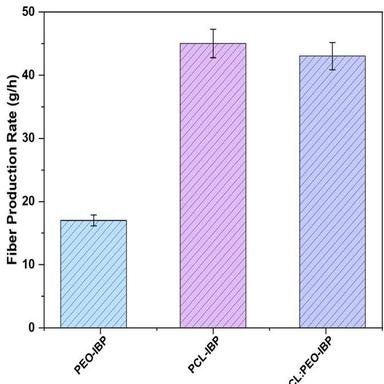
Production rate of PEO-IBP, PCL-IBP and PCL:PEO-IBP composites produced by pressurized gyration.